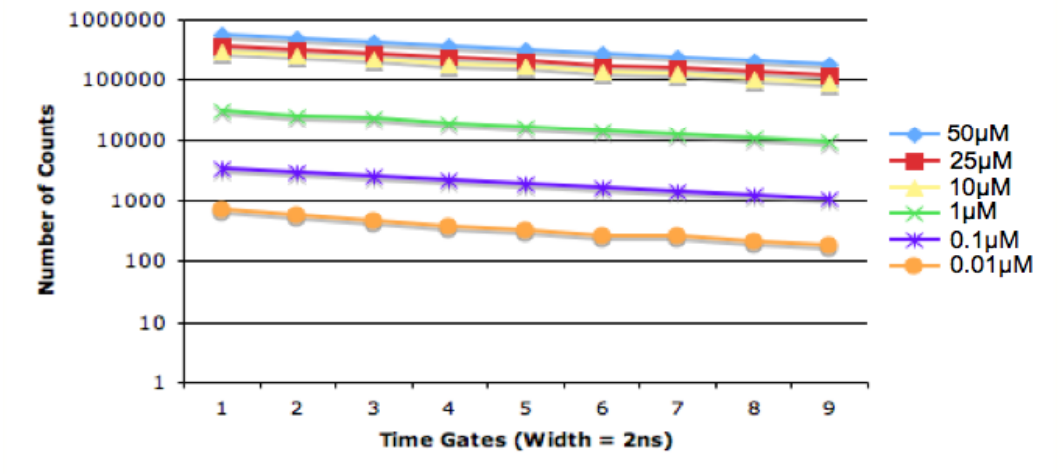
Figure 14. Fluorescence lifetime measurements, obtained from quantum dot samples using SPAD detector and on-chip circuitry.